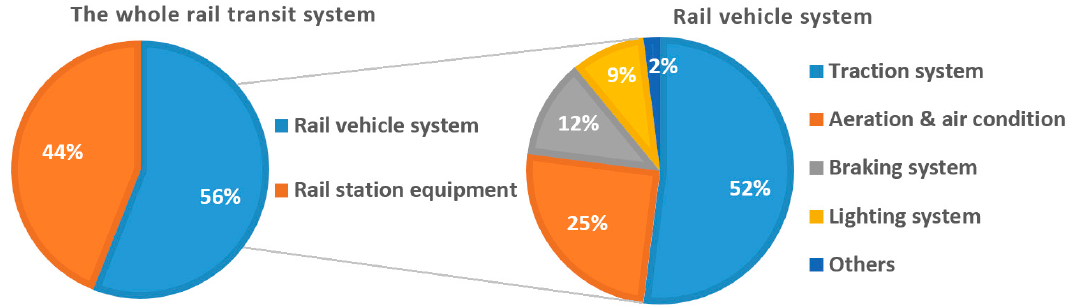
Figure 1. Constitution of energy consumption for the whole urban rail transit system and the rail vehicle system in the Beijing Metro system.